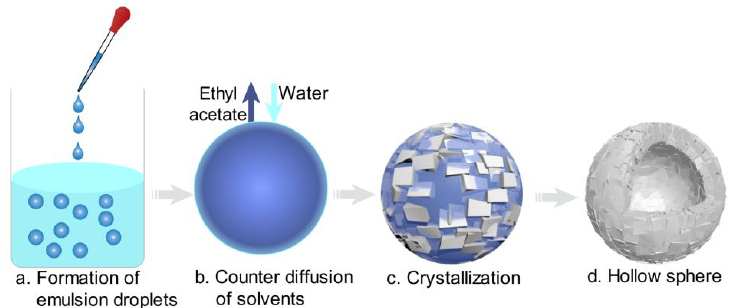
Figure 6. Mechanism schematic of hollow spherical crystals (cyan: water; blue: bridging liquid; gray: crystal).